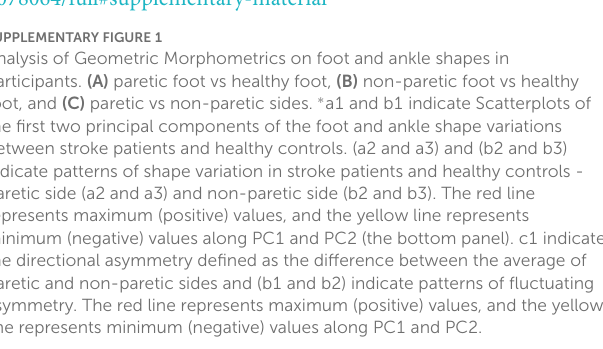
SUPPLEMENTARYFIGURE1 Analysis of Geometric Morphometrics on foot and ankle shapes in participants. (A) paretic foot vs healthy foot, (B) non-paretic foot vs healthy foot, and (C) paretic vs non-paretic sides. ∗ a1 and b1 indicate Scatterplots of the first two principal components of the foot and ankle shape variations between stroke patients and healthy controls. (a2 and a3) and (b2 and b3) indicate patterns of shape variation in stroke patients and healthy controls - paretic side (a2 and a3) and non-paretic side (b2 and b3). The red line represents maximum (positive) values, and the yellow line represents minimum (negative) values along PC1 and PC2 (the bottom panel). c1 indicate the directional asymmetry defined as the difference between the average of paretic and non-paretic sides and (b1 and b2) indicate patterns of fluctuating asymmetry. The red line represents maximum (positive) values, and the yellow line represents minimum (negative) values along PC1 and PC2. SUPPLEMENTARYFIGURE2 Subject’s Foot placement during 3D scanning